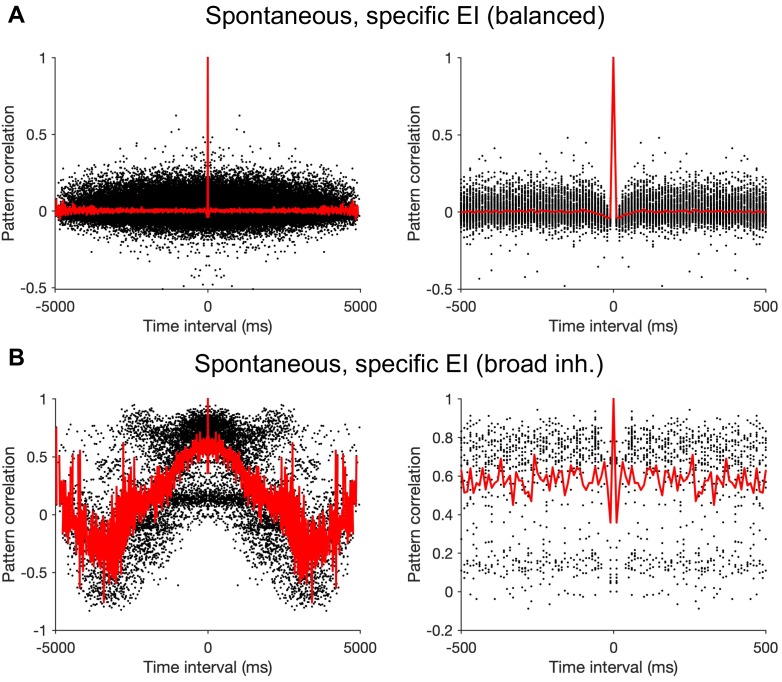
Time scale of transitions between selective states during spontaneous activity.(A) Pattern correlations of excitatory neurons as a function of the time interval between each pair of patterns. For each pair of highly selective excitatory population patterns (defined as pop. OSI > 0.5), the correlation coefficient between the population activity and the time interval between their occurrence is calculated (black dots). Average pattern correlations are calculated for different pairs of population activity patterns at a given time interval (red). Right: A zoomed in version to show shorter time scales of pattern correlations. Parameters of connectivity are the same as Figure 6B (mEE = mEI = mIE=mII = 1). J = 1 and simulation time is 5s. Other parameters are the same as Figure 6. (B) Same as (A), but for a network connectivity with sharper EE connectivity than the rest: mEE = 1, mEI = mIE = mII=0.5.